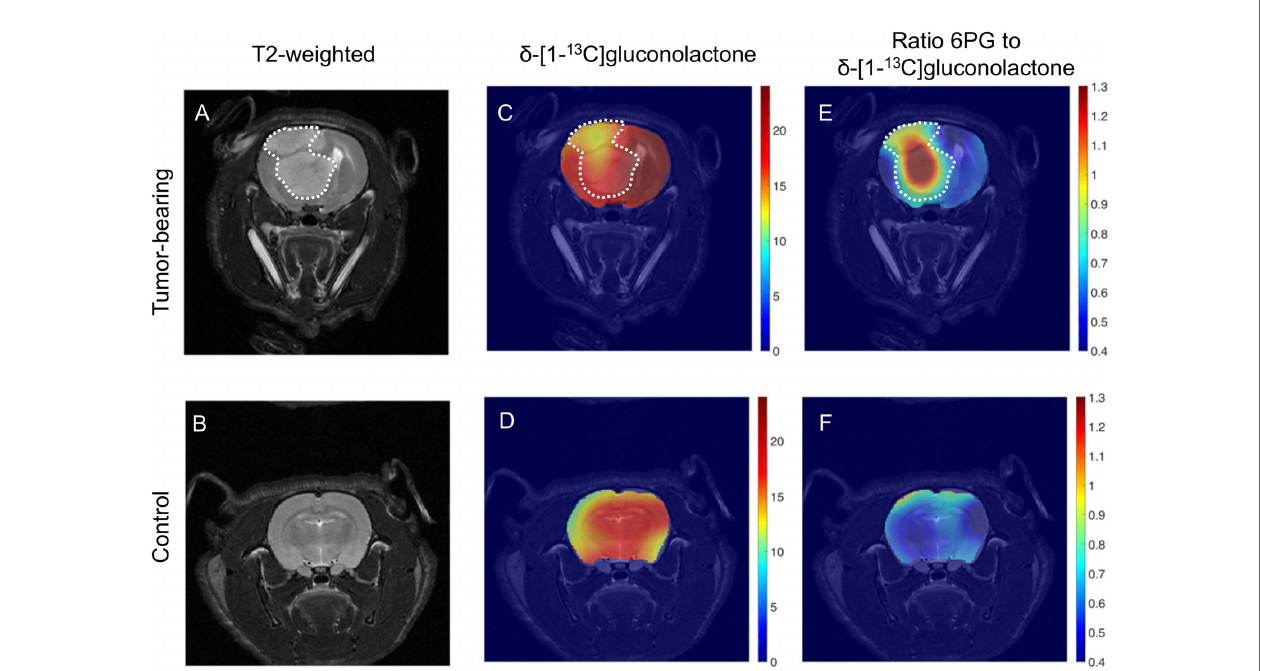
FIGURE 8 | Metabolic imaging of glioblastoma tumors in vivo using hyperpolarized d -[1- 13 C]gluconolactone. Representative T2-weighted MRI (A, B) and metabolic heatmaps of the SNR of d -[1- 13 C]gluconolactone (C, D) and the ratio of [1- 13 C]6PG, to d -[1- 13 C]gluconolactone (E, F) from a rat bearing an orthotopic U87 tumor or tumor free healthy control. The tumor region is contoured by white dotted